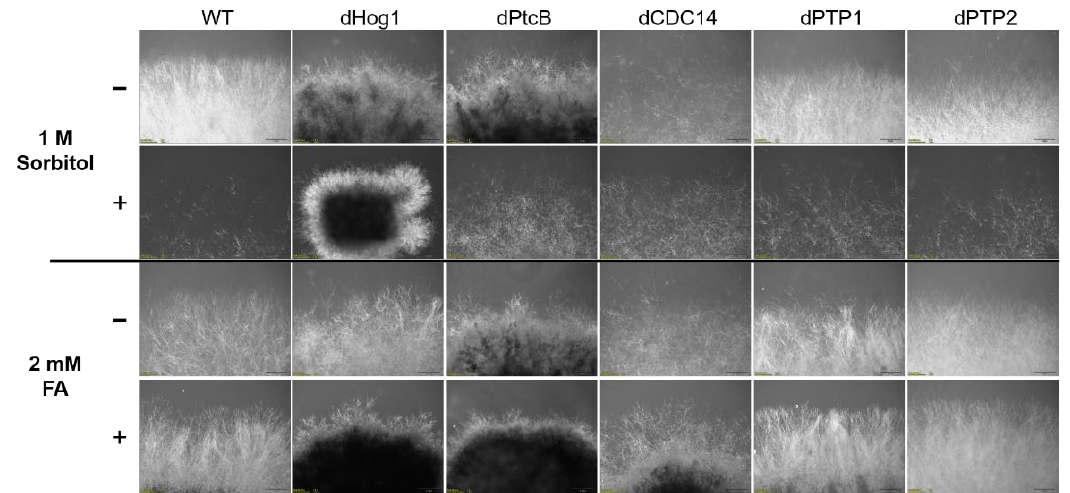
Figure 5. Morphology of the colony margins. The cultures were grown on CM agar plates with or without sorbitol (− or + 1 M sorbitol), or CM with 0.15% v/v DMSO with or without FA (− or + 2 mM FA). The pictures were taken 5 days after the inoculum transfer.